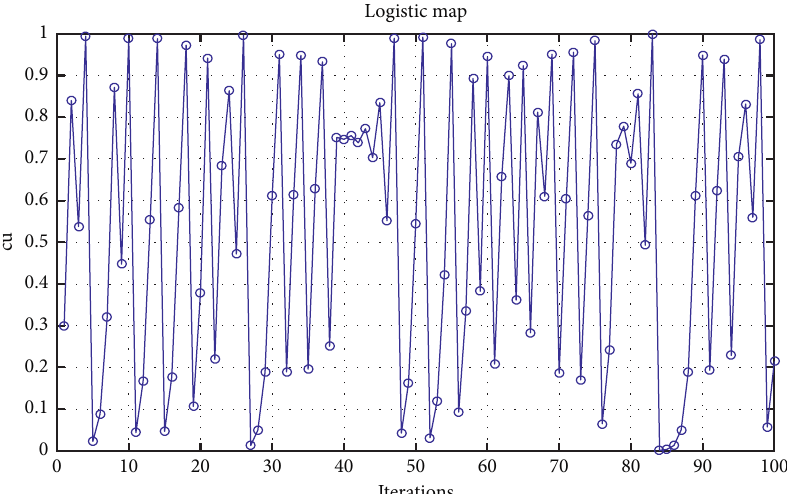
Figure 3: Visualization of logistic